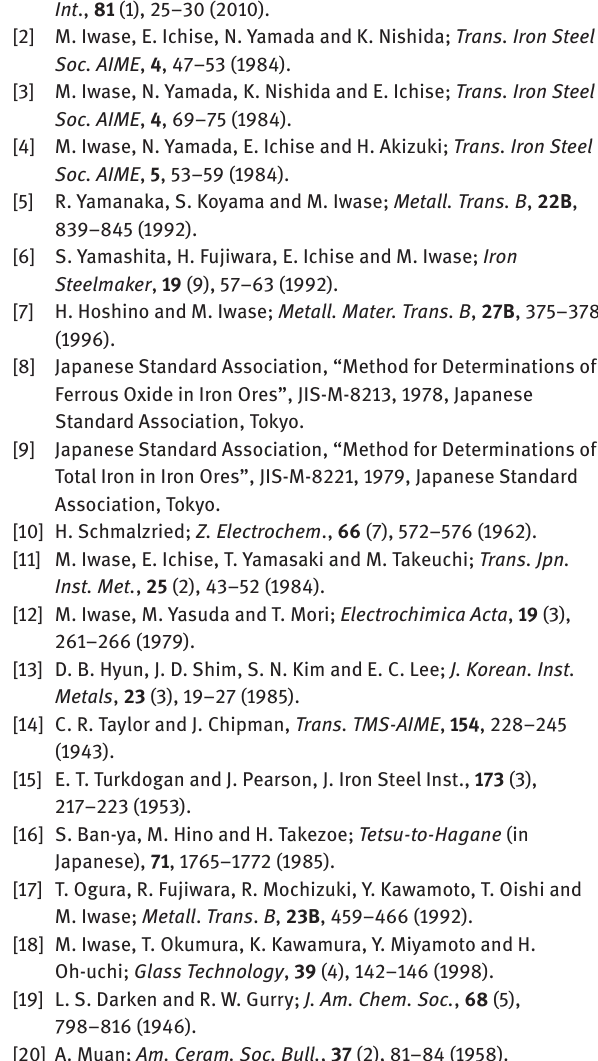
Fig. 6: Relation between log{ (Fe 3 + ) / (Fe 2 + ) P O2 1/4 } and X FexO at 1673